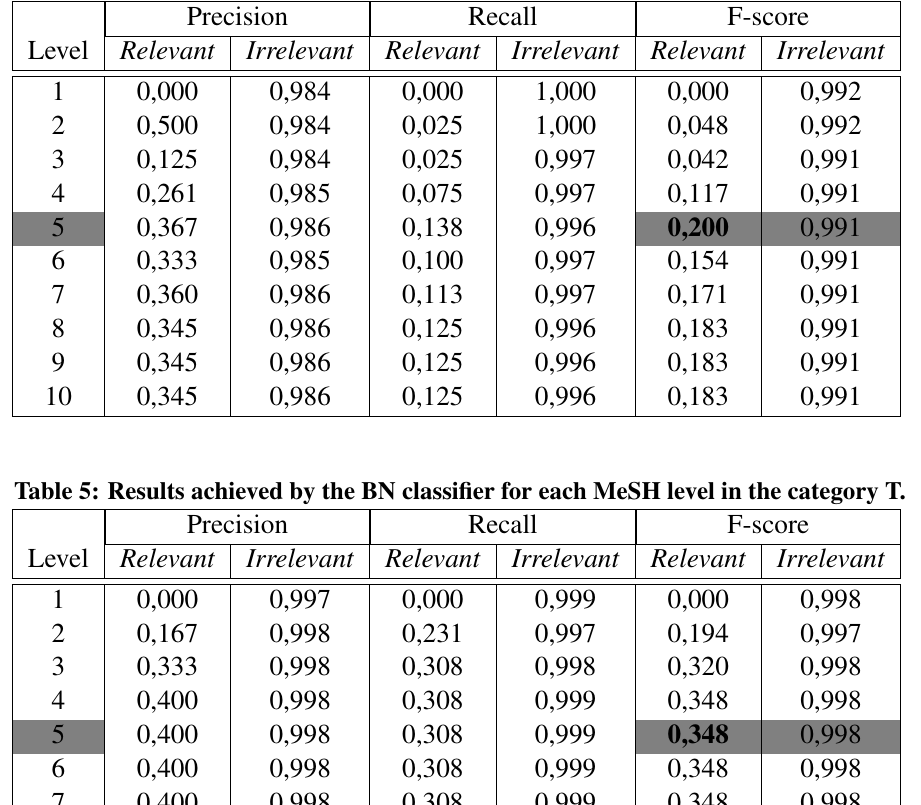
Table 4: Results achieved by the BN classifier for each MeSH level in the category E.